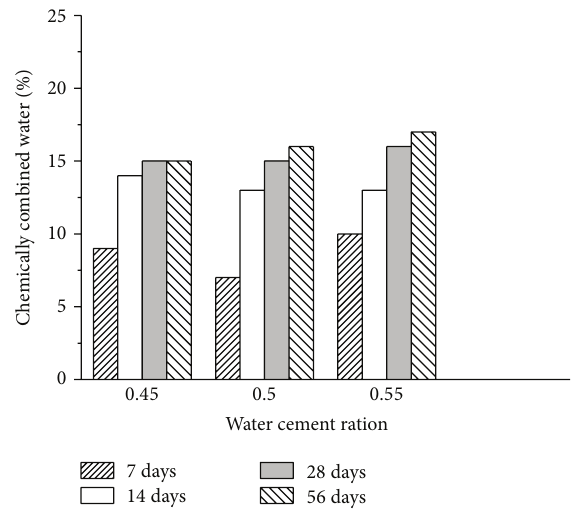
Figure 13: The influence of water to cement ratio on the CCW of cement paste close to